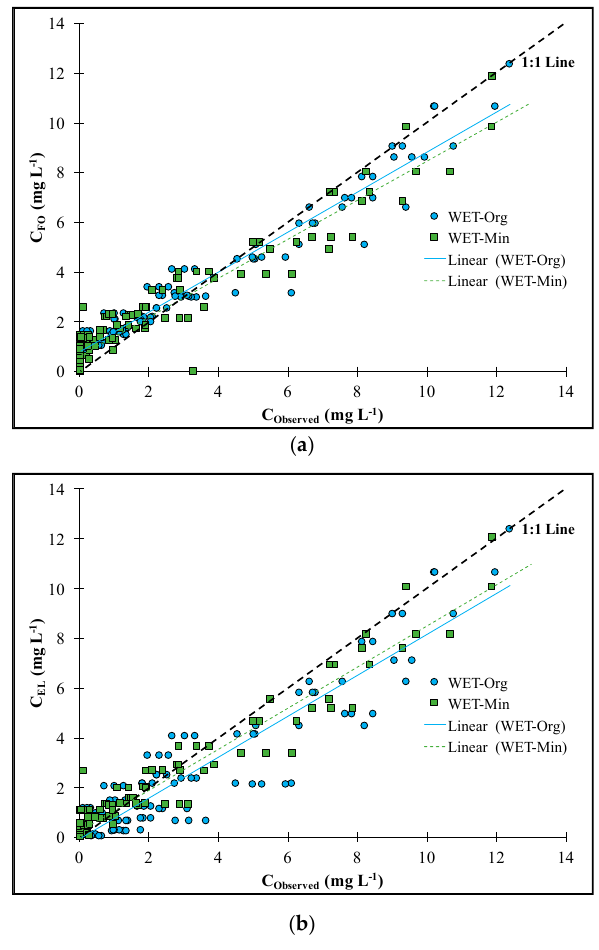
Figure 3. Regression of the ( a ) first order decay and ( b ) efficiency loss kinetic models for correlating predicted and observed NO 3 -N removal rates for the WET-Org and WET-Min restored wetland systems. mesocosm